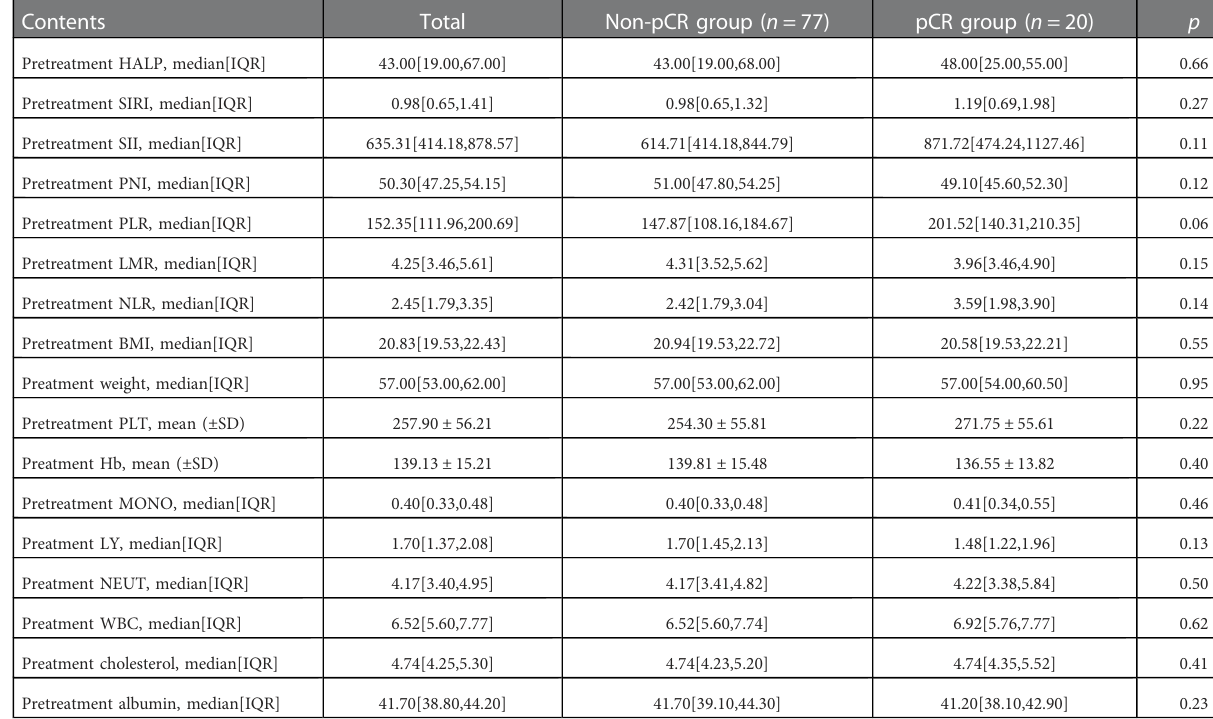
TABLE 2 Comparisons of preteratment in fl ammatory and nutritional indicators between the pCR group and non-pCR